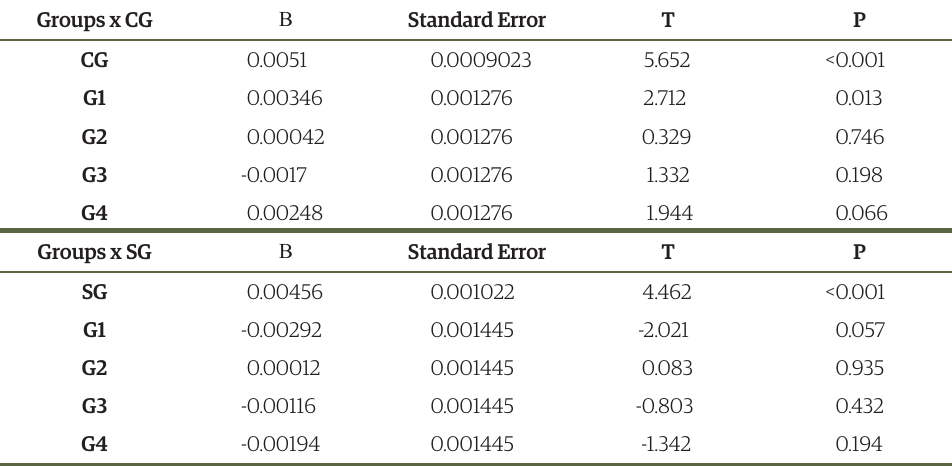
table 1. Results of the linear model comparing the effects of each treatment with those in the control and sham